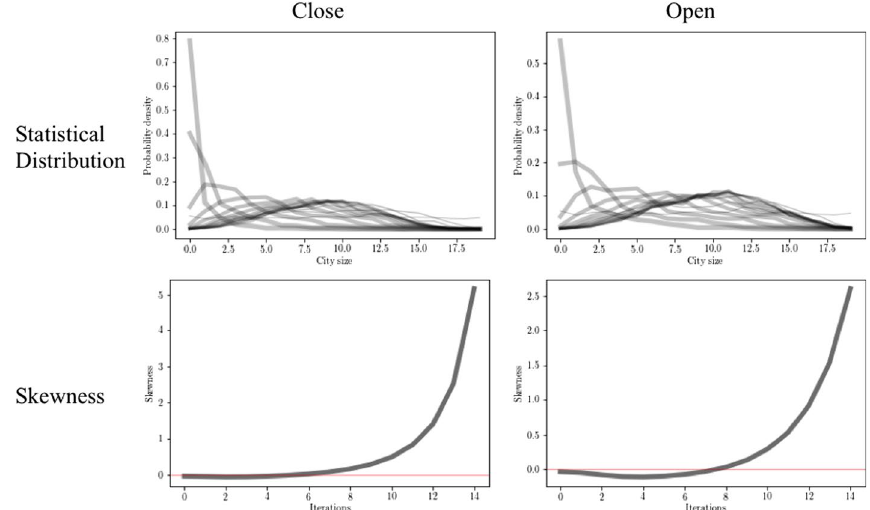
Fig. 6 Base cases. Dynamics of the statistical distributions and skewness. The skewness was computed by the Fisher‑Pearson coefficient scipy.stats.skew. Each value of skewness is associated with each curve of statistical distribution per